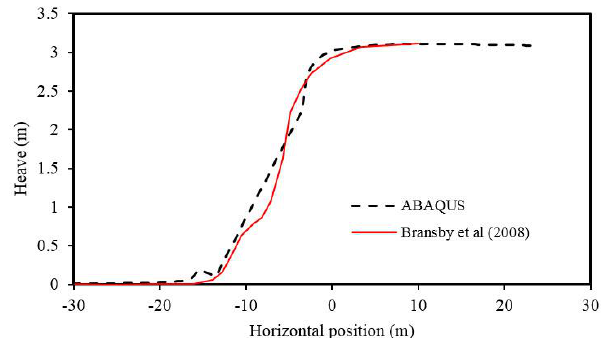
Fig 7. Comparison of results of numerical and experimental